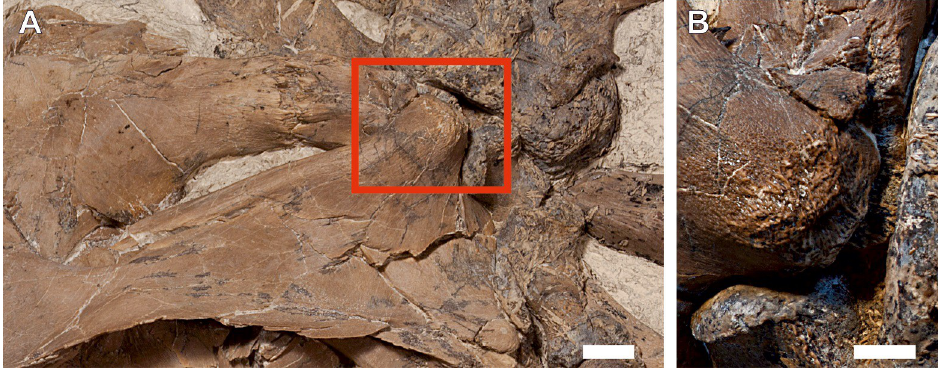
Fig 11. Supratemporal bone of Thalassodraco etchesi , MJML K 1885. A, posterodorsal portion of the skull, with red box indicating the protuberance of the supratemporal. B, rugose texture on the supratemporal protuberance. Scale bar A, 10 mm; B, 5